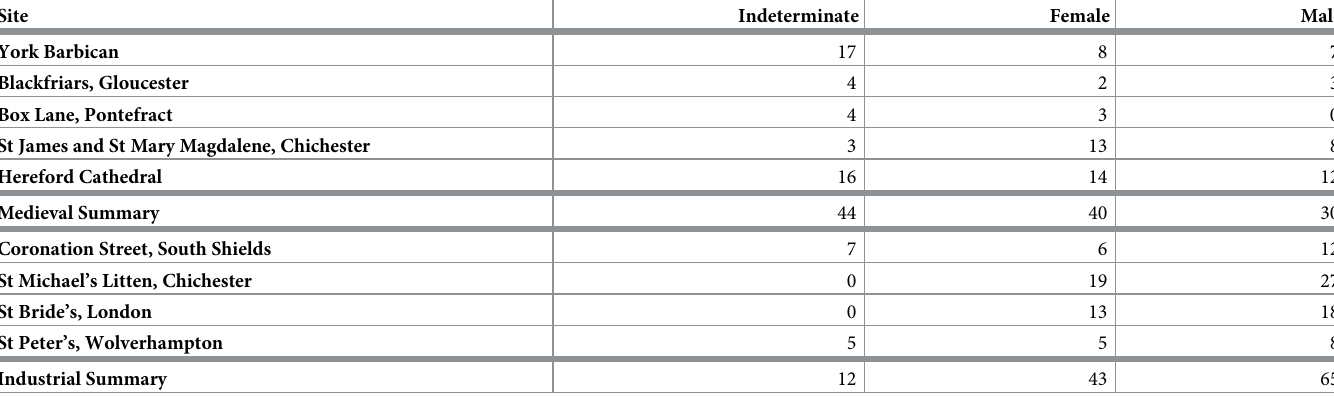
Table 2. Sex distribution of the individuals selected from the assemblages examined and used to perform OFA. Site